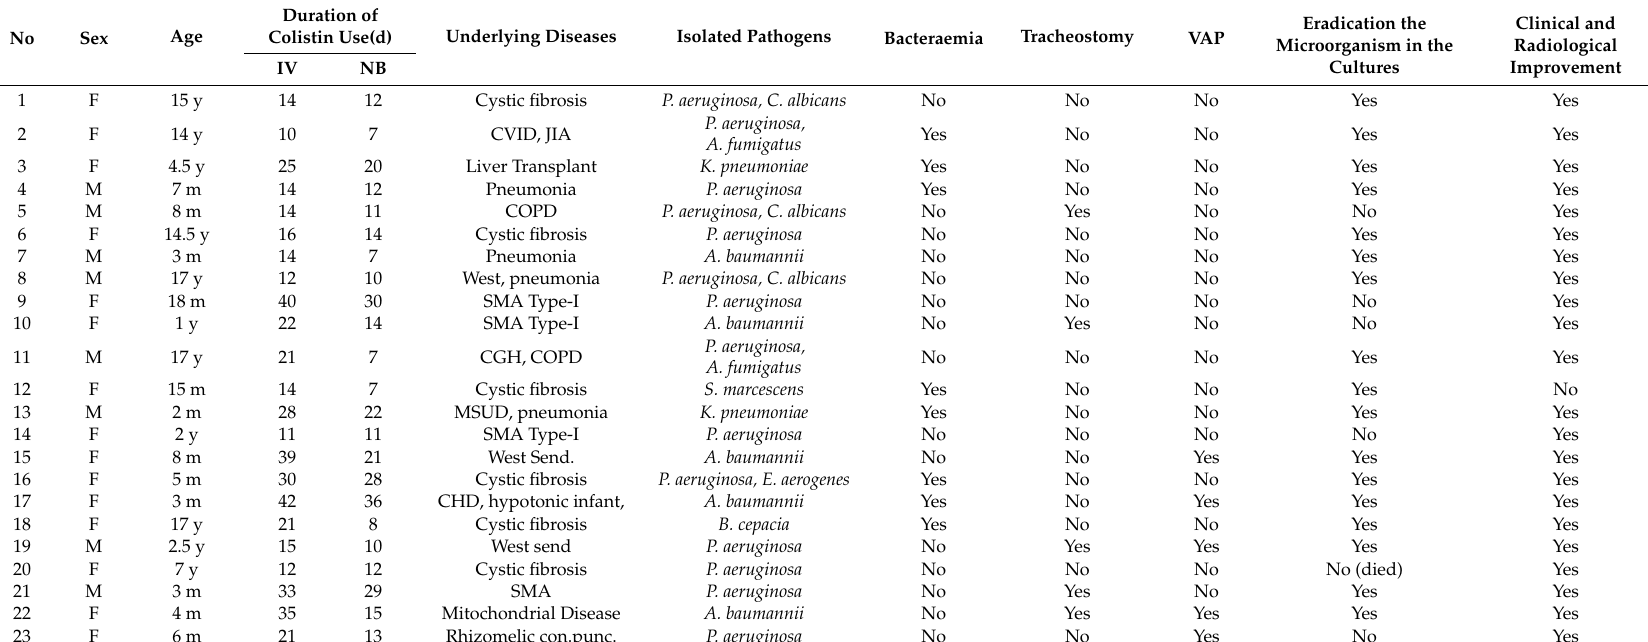
Table 3. Characteristics of the patients with nebulised colistin